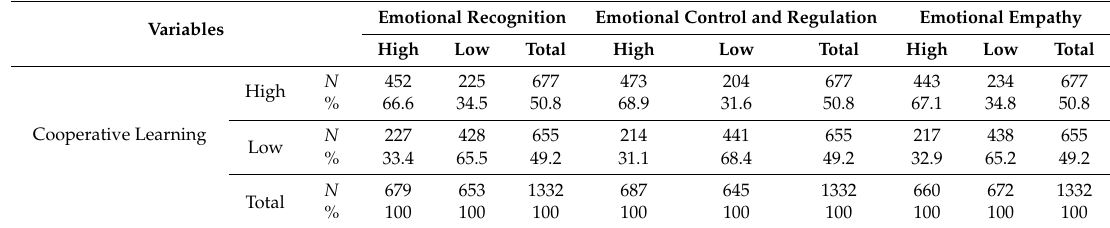
Table 3. Recount of classified participants and percentage sample distribution.